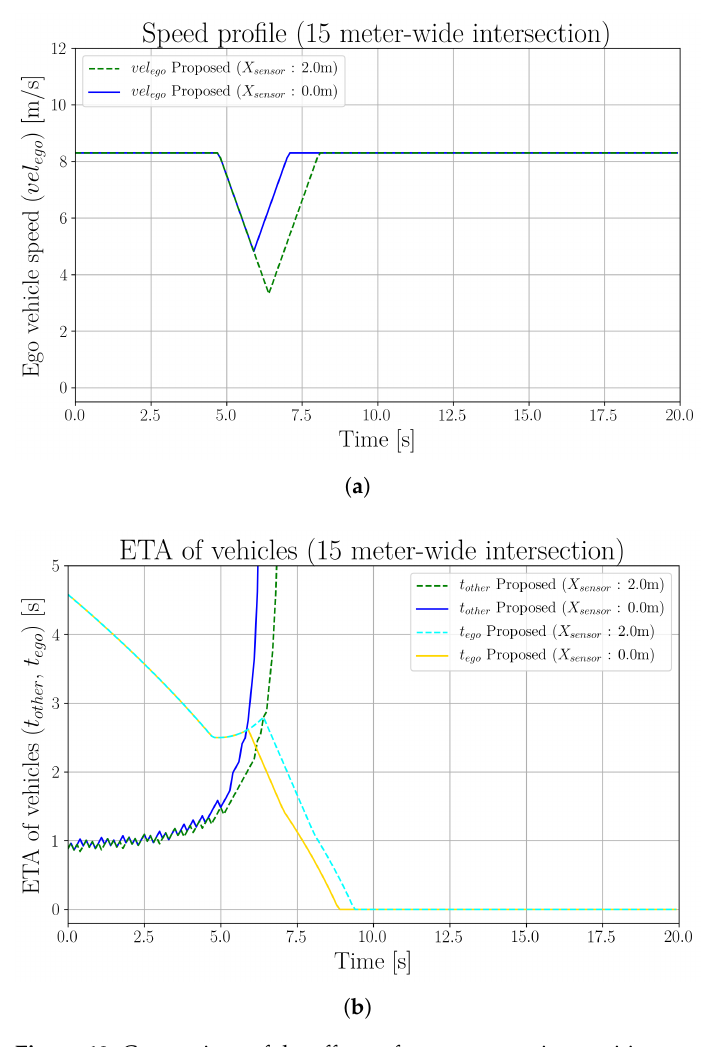
Figure 19. Comparison of the effects of sensor mounting position on planner output at a 15 m wide occluded intersection, with the sensor located on the roof (2 m from front bumper) vs. on the front bumper (0 m from front bumper). ( a ) Ego vehicle speed profiles at a 15 m wide occluded intersection. ( b ) Estimated times of arrival of vehicles at a 15 m wide occluded